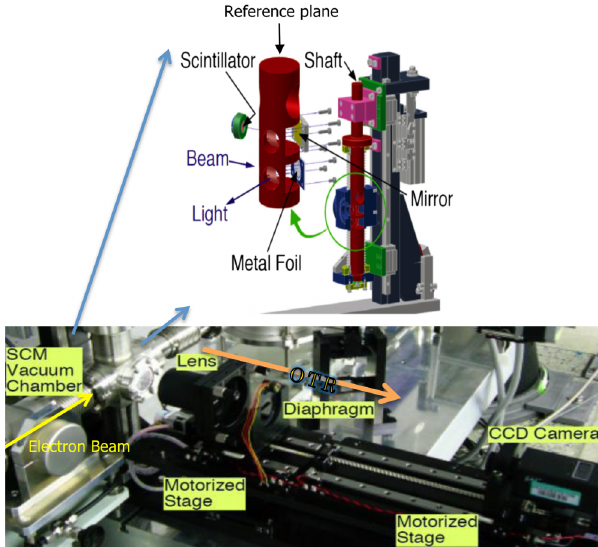
FIG. 7. Mechanical structure in the vacuum chamber and the optical system for the